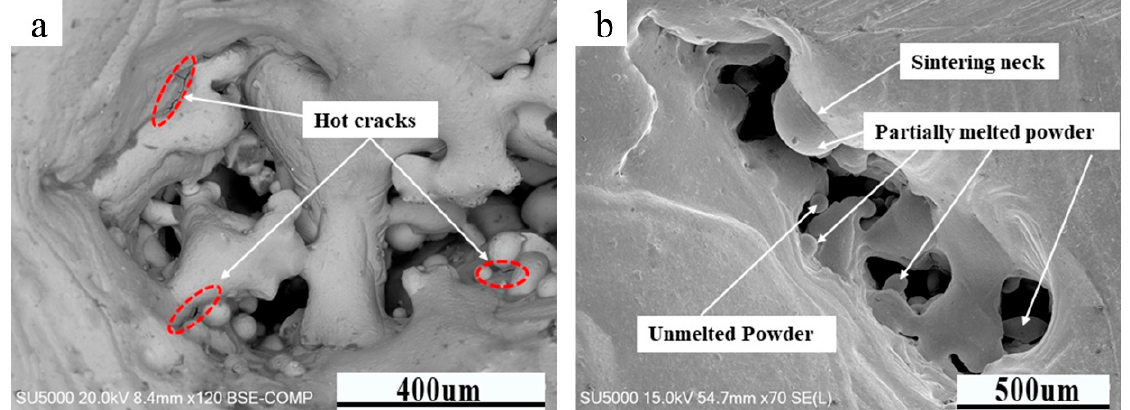
Figure 6. The internal structure of pore defects: ( a ) hot cracks; ( b ) unmelted powder, partially molten powder, and sintered neck.